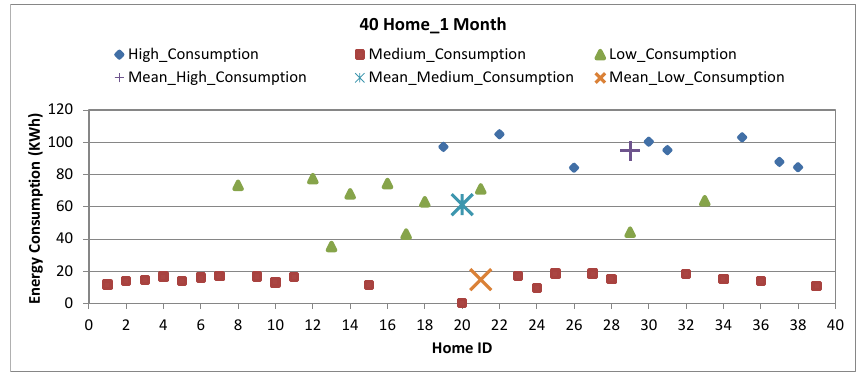
Figure 9. Results of one month cluster data